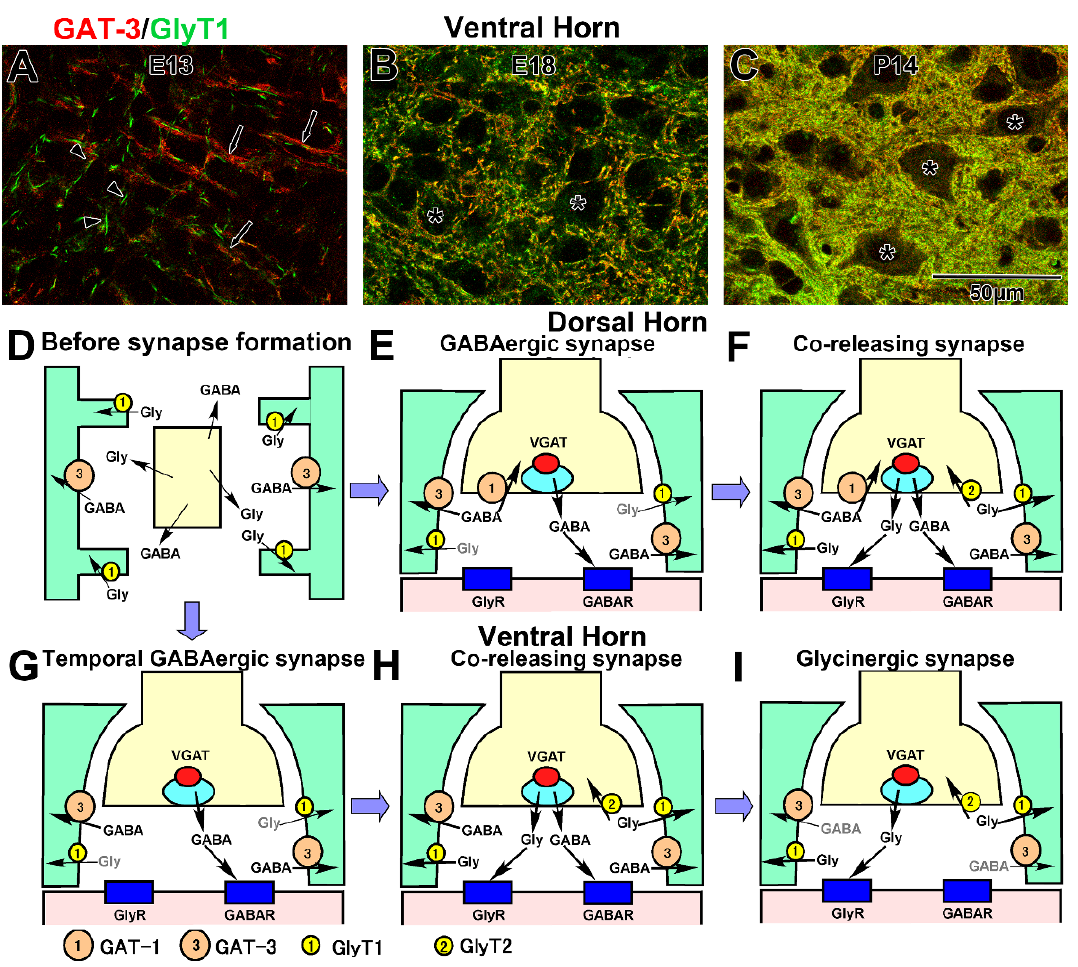
Figure 5. Developmental formation of the GABA and glycine removal system. ( A – C ) Double staining of GAT-3 (red) and GlyT1 (green). GAT-3 is localized at the shaft of the radial glial processes (arrows), whereas GlyT1 is localized at the spines of the processes (arrowheads) at E13. As development proceeds, GAT-3 and GlyT1 immunolabelings gradually merge and surround the motor neurons (asterisks in B , C ). ( D – I ) Schematic illustrations of the development of the GABA and glycine removal system. Initially, uptake of extrasynaptically released GABA and glycine occurs at the shafts and spines of radial glial processes, respectively ( D ). In the ventral horn, GAT-1 is localized at the terminals when GABAergic synapses are formed ( E ). After the GABAergic synapses convert to coreleasing synapses, GlyT2 is additionally localized at the terminals ( F ). In contrast, in the ventral horn, GAT-1 is not localized at the terminals even though GABA is synthesized and released in the temporally synapses. After the synapses convert to coreleasing synapses, GlyT2 is also additionally localized at the terminals ( G ). Even after coreleasing synapses changed to glycinergic synapses, GAT-3 continued to be localized at the astroglial sheets ( I